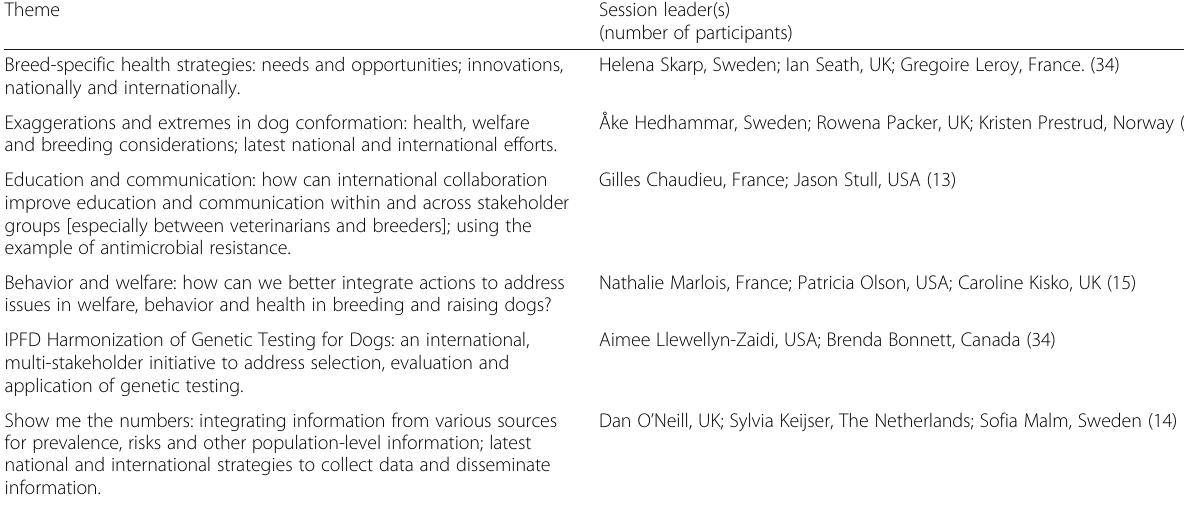
(number of participants)